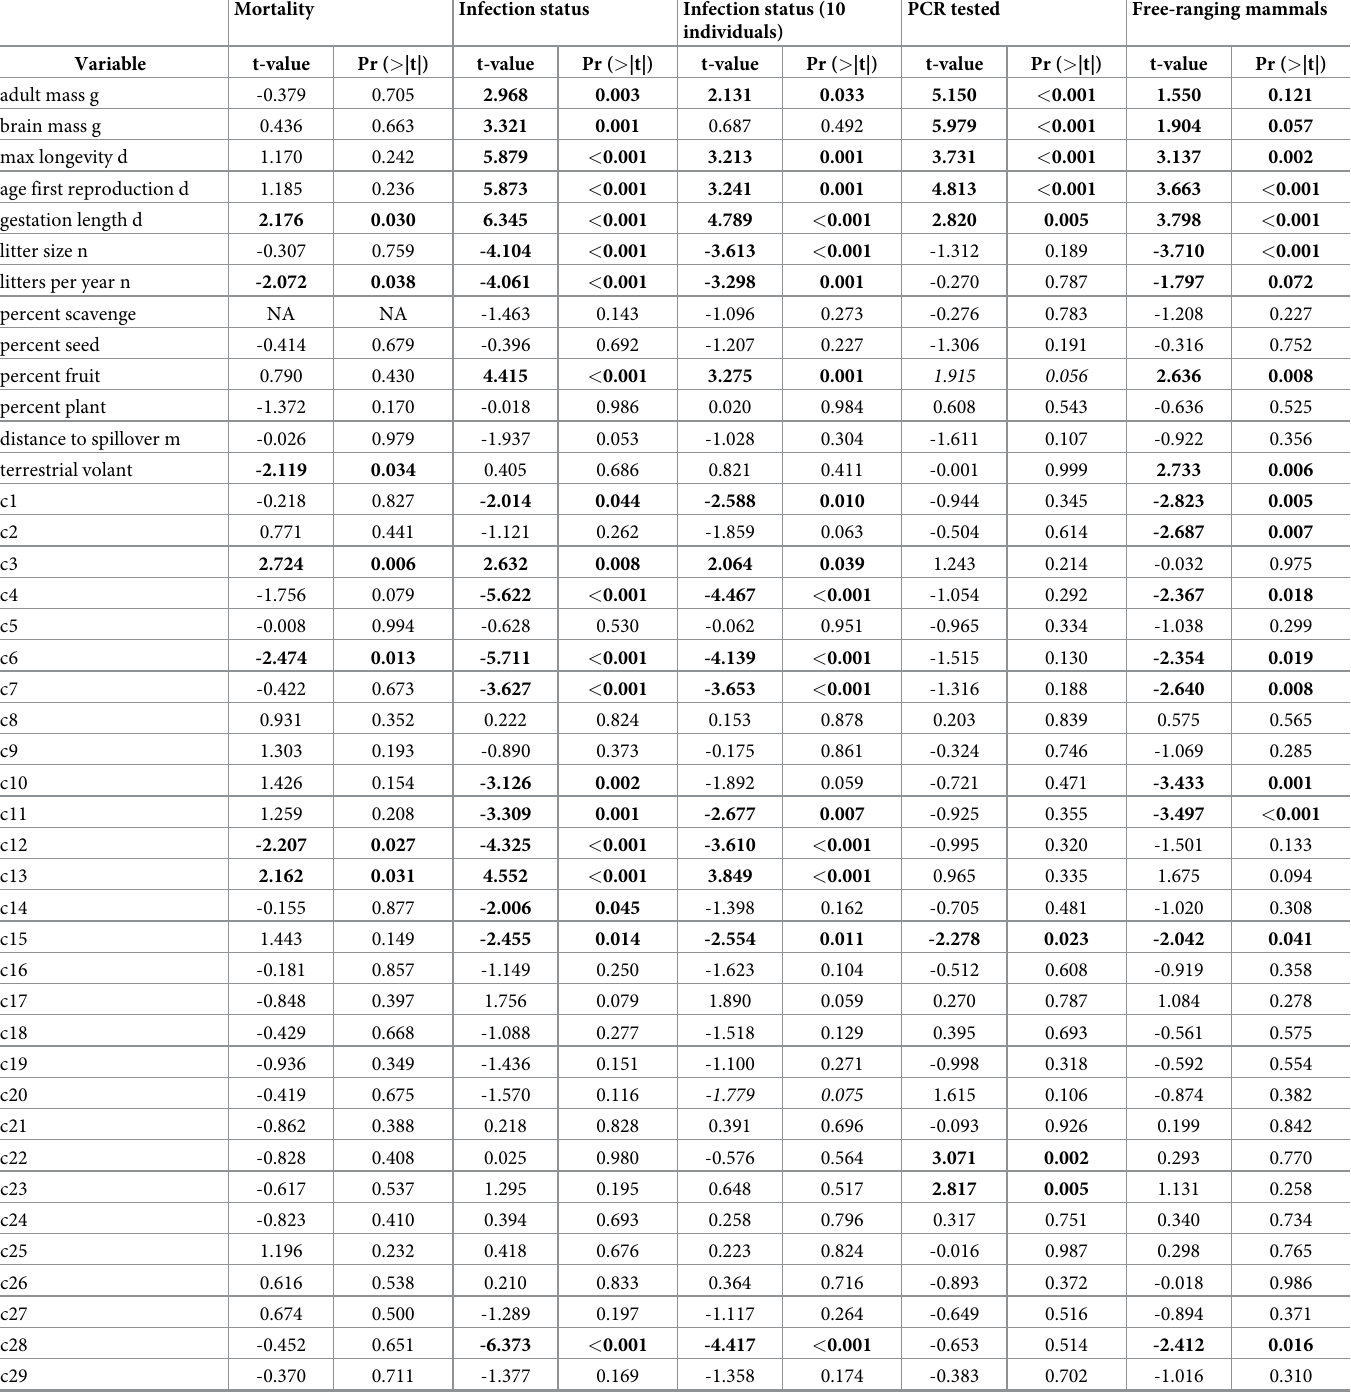
Table 2. Summary of ridge regression models. For each response variable, namely mortality, infection status, infection status for 10 or more individuals, infection status determined from PCR tests only and infection status predicted for free-ranging mammals, table summarizes the t-statistic of coefficient estimates of predictors and accom- panying p-value. Coefficients for 31 eigenvectors (c1-c31) provided in table even though model was run with the first 48 phylogenetic eigenvectors; higher eigenvector coef- ficients for variables c32-c48 were always non-significant and therefore excluded from table. Bold faced numbers represent significance at α of 0.05. Italicized numbers represent significance at α of 0.1. NA represents coefficients that were not fit in